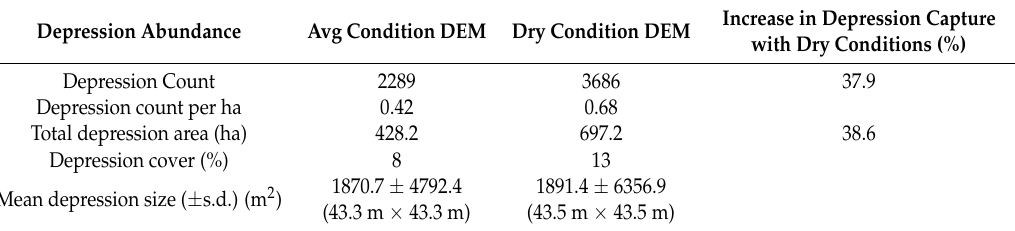
Table 4. A comparison between depression abundance and area derived using a lidar digital elevation model (DEM) collected during average wetness conditions and a lidar DEM collected during dry conditions a across a subset (5421 ha) of the Upper Choptank River